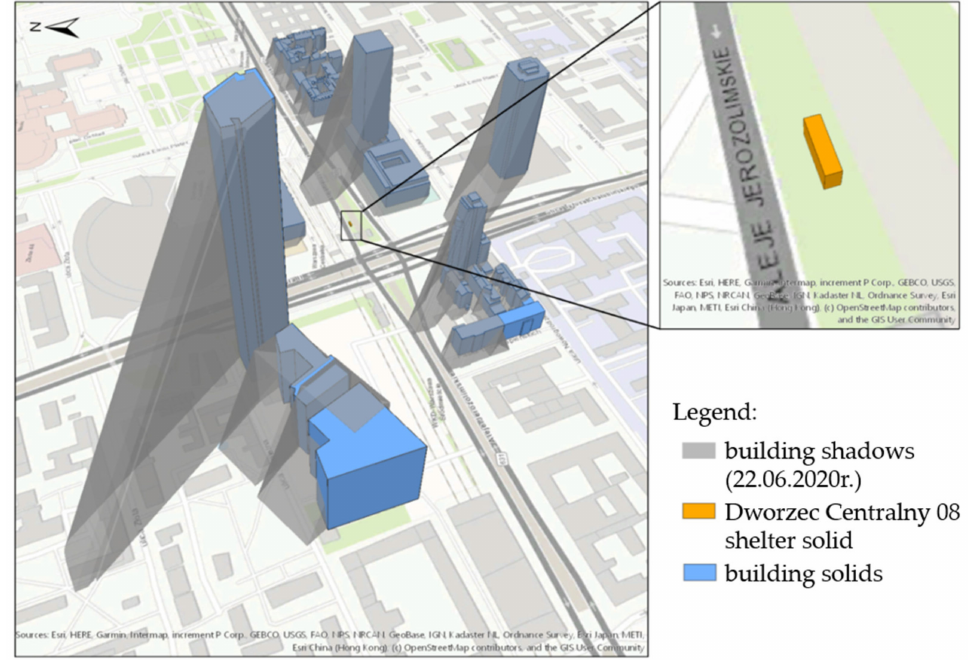
Figure 20. Arrangement of buildings and their shadows for the neighbourhood of Dworzec Centralny 08 tram stop generated for 22 June 2020 at 10:30